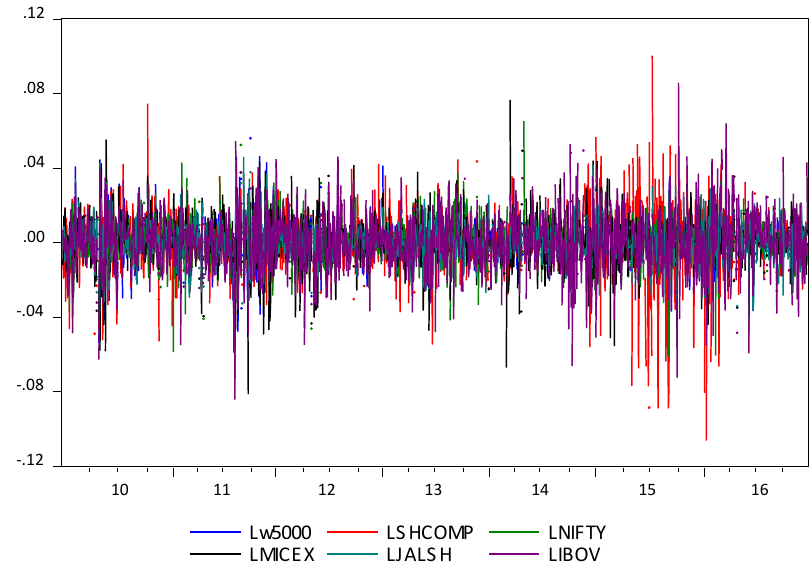
Figure 1. Stationary series data at first